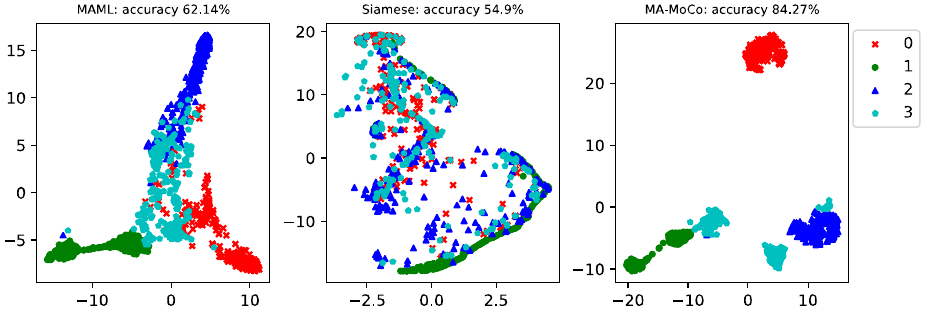
Figure 4. A 4-way 1-shot diagnosis of the generator bearing data when the training set of each class has only 10 fault samples.